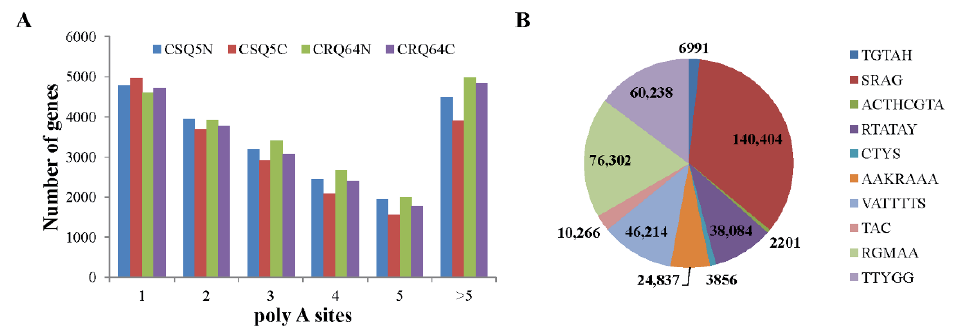
Figure 2. Distribution of poly A sites in CSQ5 and CRQ64. ( A ) Distribution of the numbers of poly A sites in genes found in the different strains and conditions; ( B ) motifs in the top 10 alternatively polyadenylated sites.